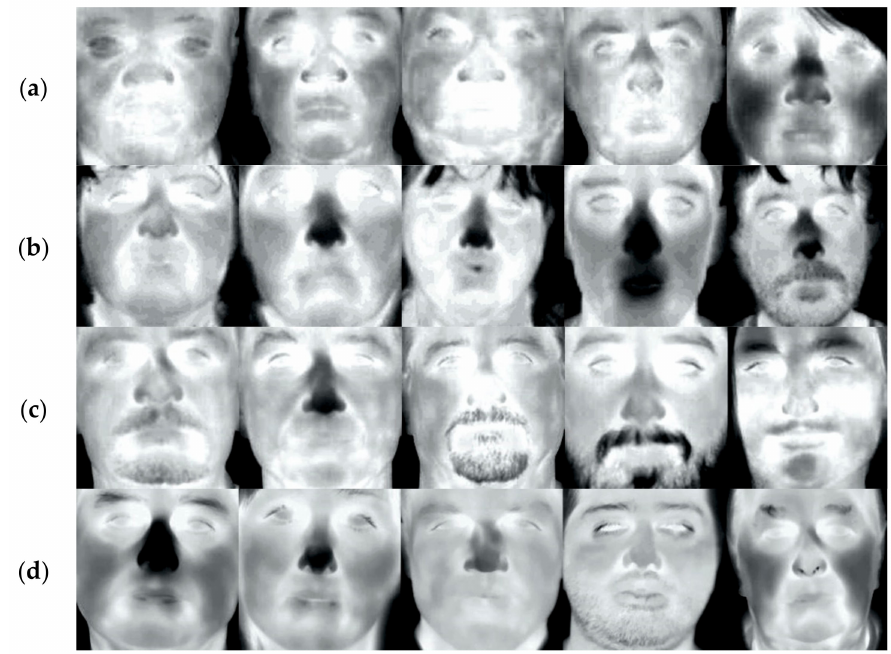
Figure 1. Gallery of thermal face images from ( a ) PROTECT dataset, ( b ) CARL dataset, ( c ) In-House (FLIR A65), ( d ) and In-House (FLIR